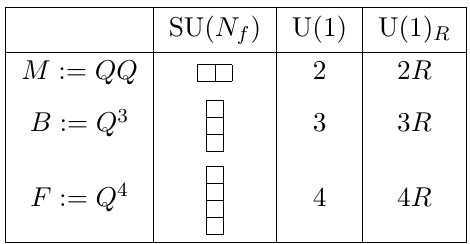
Table 2 . Gauge invariants of the 4d N = 1 G 2 gauge